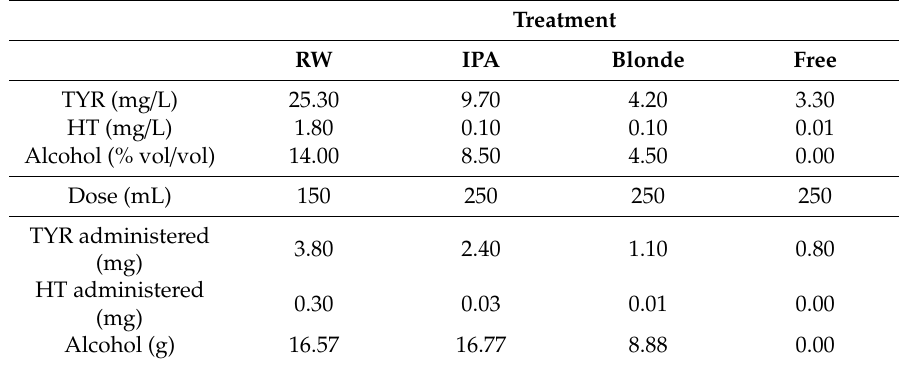
Table 1. TYR, HT, and alcohol content of wine and beers administered in the